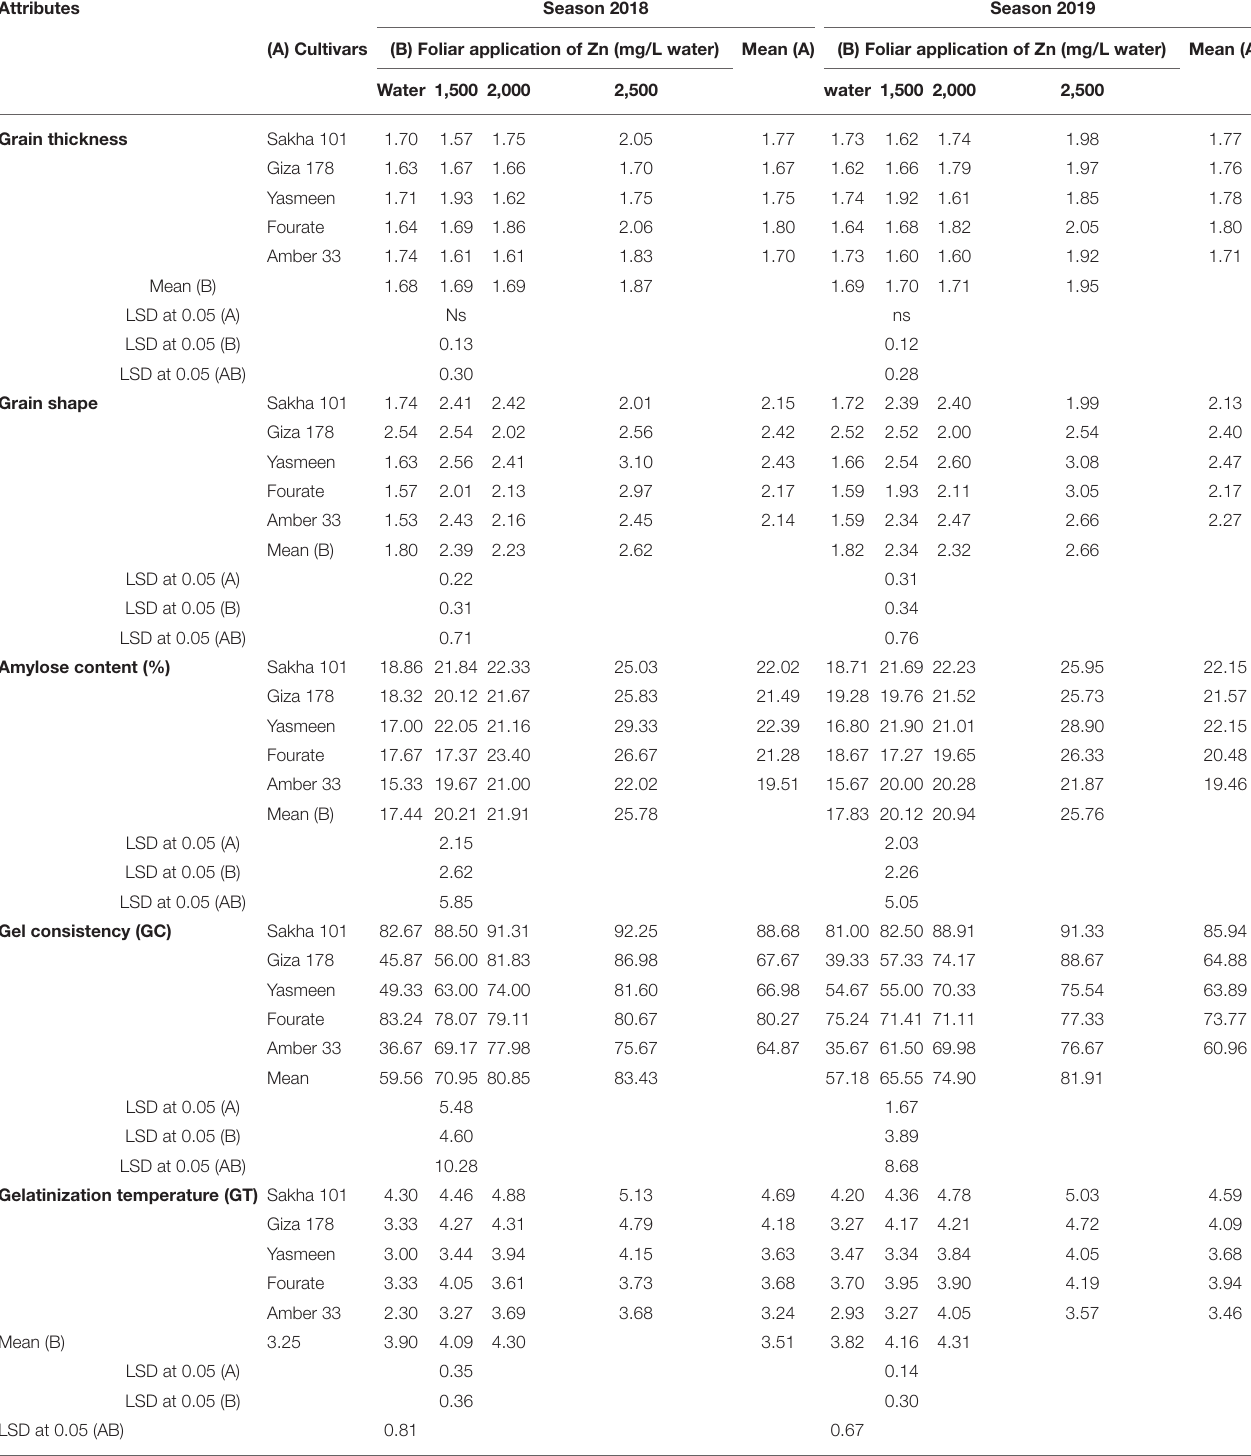
TABLE 5 | Kernel quality traits of five rice cultivars affected by the concentration of Zn during the 2018 and 2019 seasons.